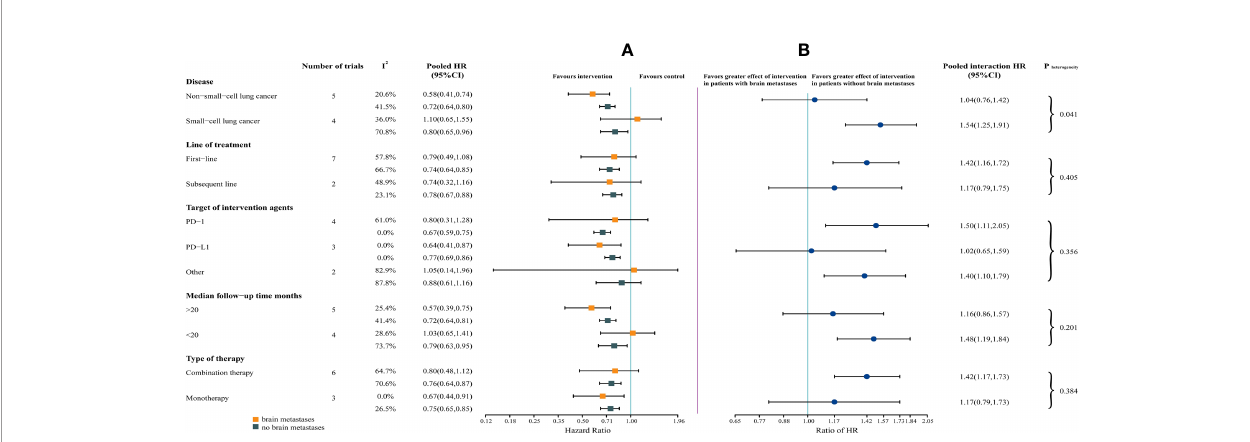
FIGURE 3 | Forest Plot of Hazard Ratios for Death According to Brain Metastases, by Subgroup. (A) Hazard Ratios (HRs) of death for patients assigned to intervention group, compared with those assigned to control group, according to brain metastases and subgroups (ie, type of therapy, type of cancer, line of therapy, median follow-up duration, and target of intervention agents). (B) The interaction between immunotherapy ef fi cacy and brain metastases, according to subgroups (ie, type of therapy, type of cancer, line of therapy, median follow-up duration, and target of intervention